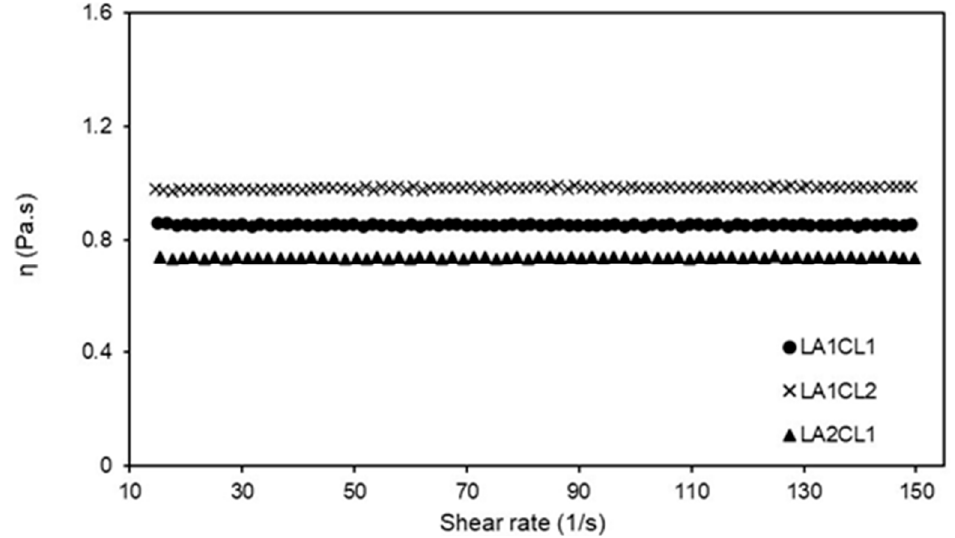
Figure 3. Viscosity of the three blends as function of shear rate, at constant temperature (25 °C).